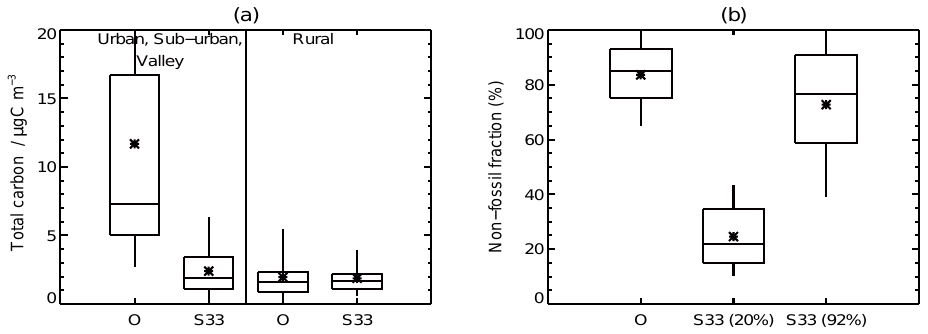
Fig. 10. Comparison of modelled (simulation 33, S33) and observed (O) (a) total carbon aerosol (left hand of panel for sites classified as urban, sub-urban and valley; right hand of panel for sites classified as rural), (b) fraction of total carbon aerosol that is non-fossil for rural sites when we assume that 20% (S33(20%)) and 92% (S33(92%)) of anthropogenically controlled SOA is non-fossil.